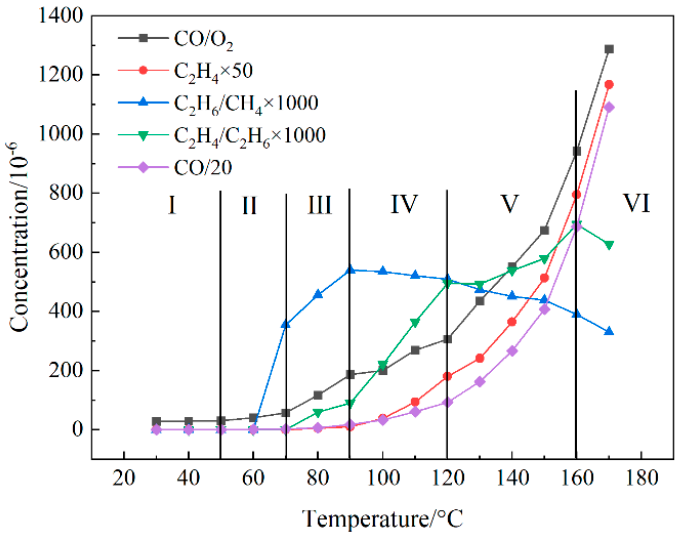
Figure 2. The division of the stages of the spontaneous combustion of coal.